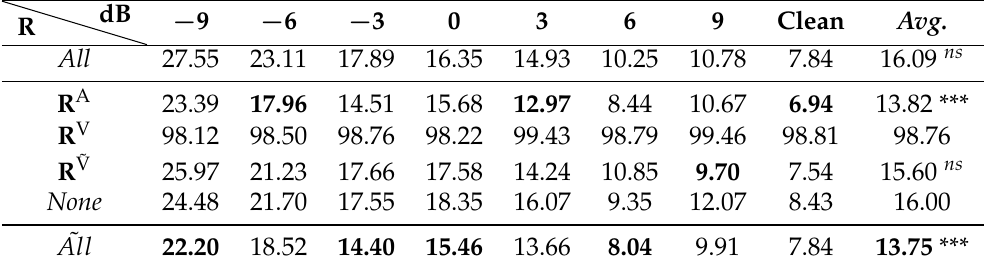
Table 7. BLSTM-DFN word error rates (%) on the LRS2 test set under additive noise. All : apply all reliability indicators as shown in Table 1; R A : all audio-based reliability indicators; R V : all video- based reliability indicators; R ˜V : using the video-based reliability indicators, excluding the image distortion estimates; ˜ All : using all reliability indicators except for image distortion estimates; None : proposed model without reliabilities. Avg : Average performance, together with the significance of improvements (compared with None ). ns : not significant and ***: p (cid:54)